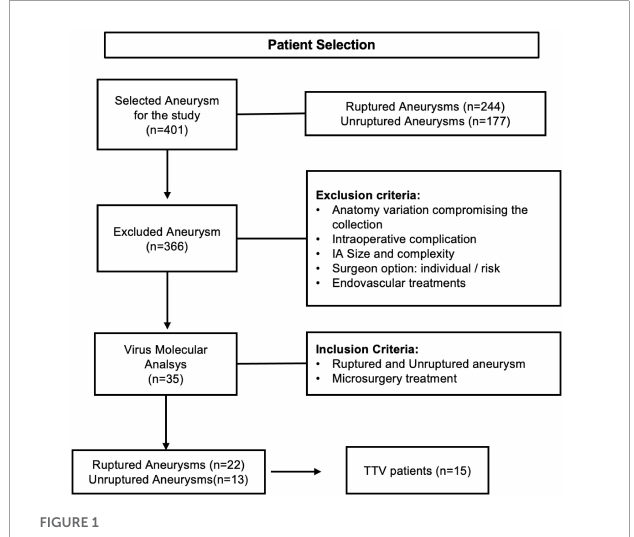
FIGURE1 Flowchart of patient selection. Inclusion and exclusion criteria and patients